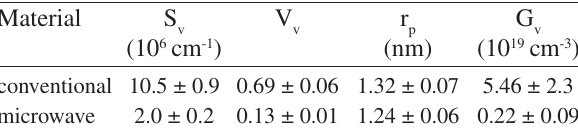
Table 3. Metric and topological parameters of silica gels.